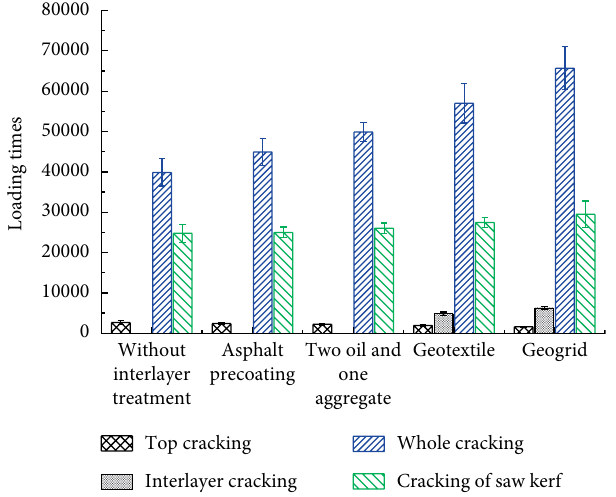
Figure 18: Comparison of treatment load fatigue test results between different layers.